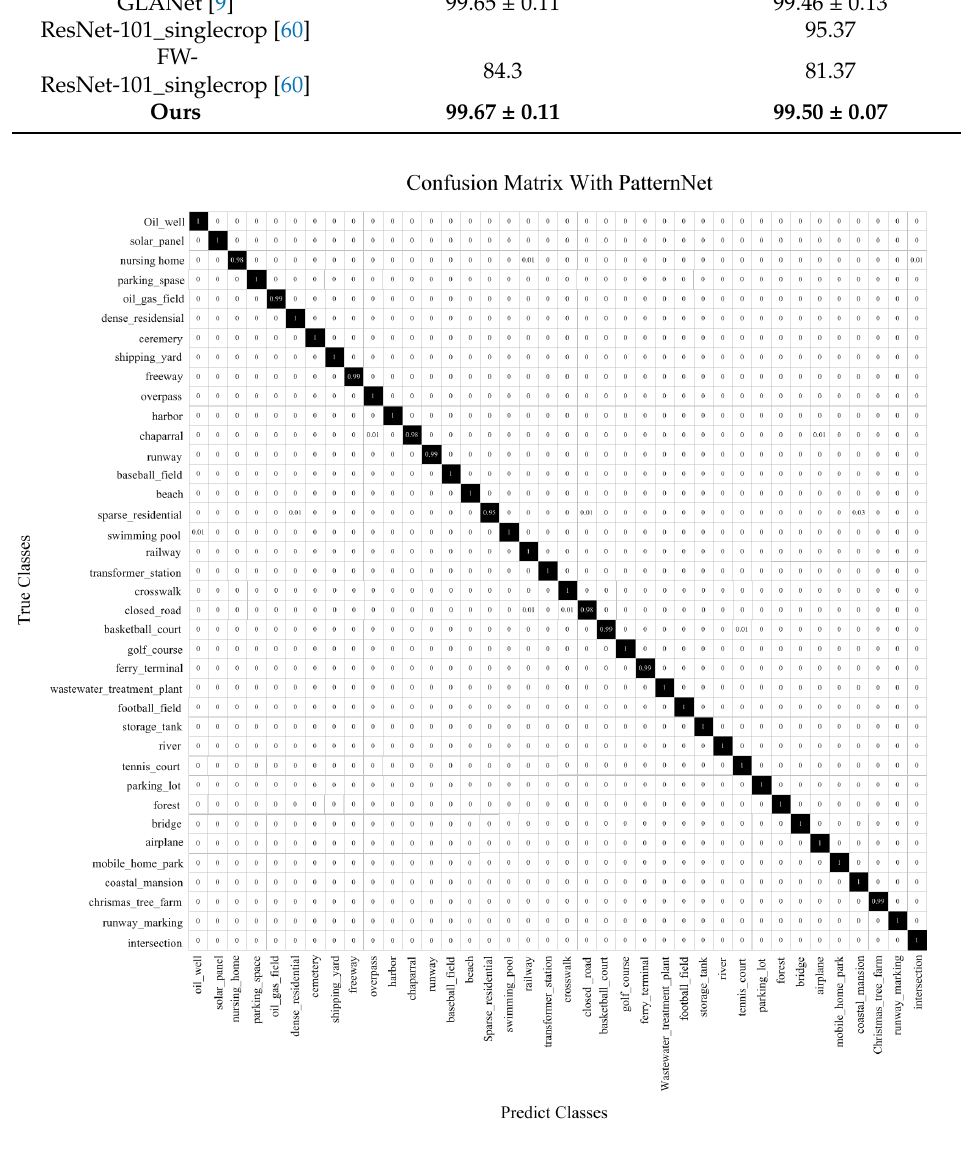
Figure 10. CM on PatternNet under the training ratio of